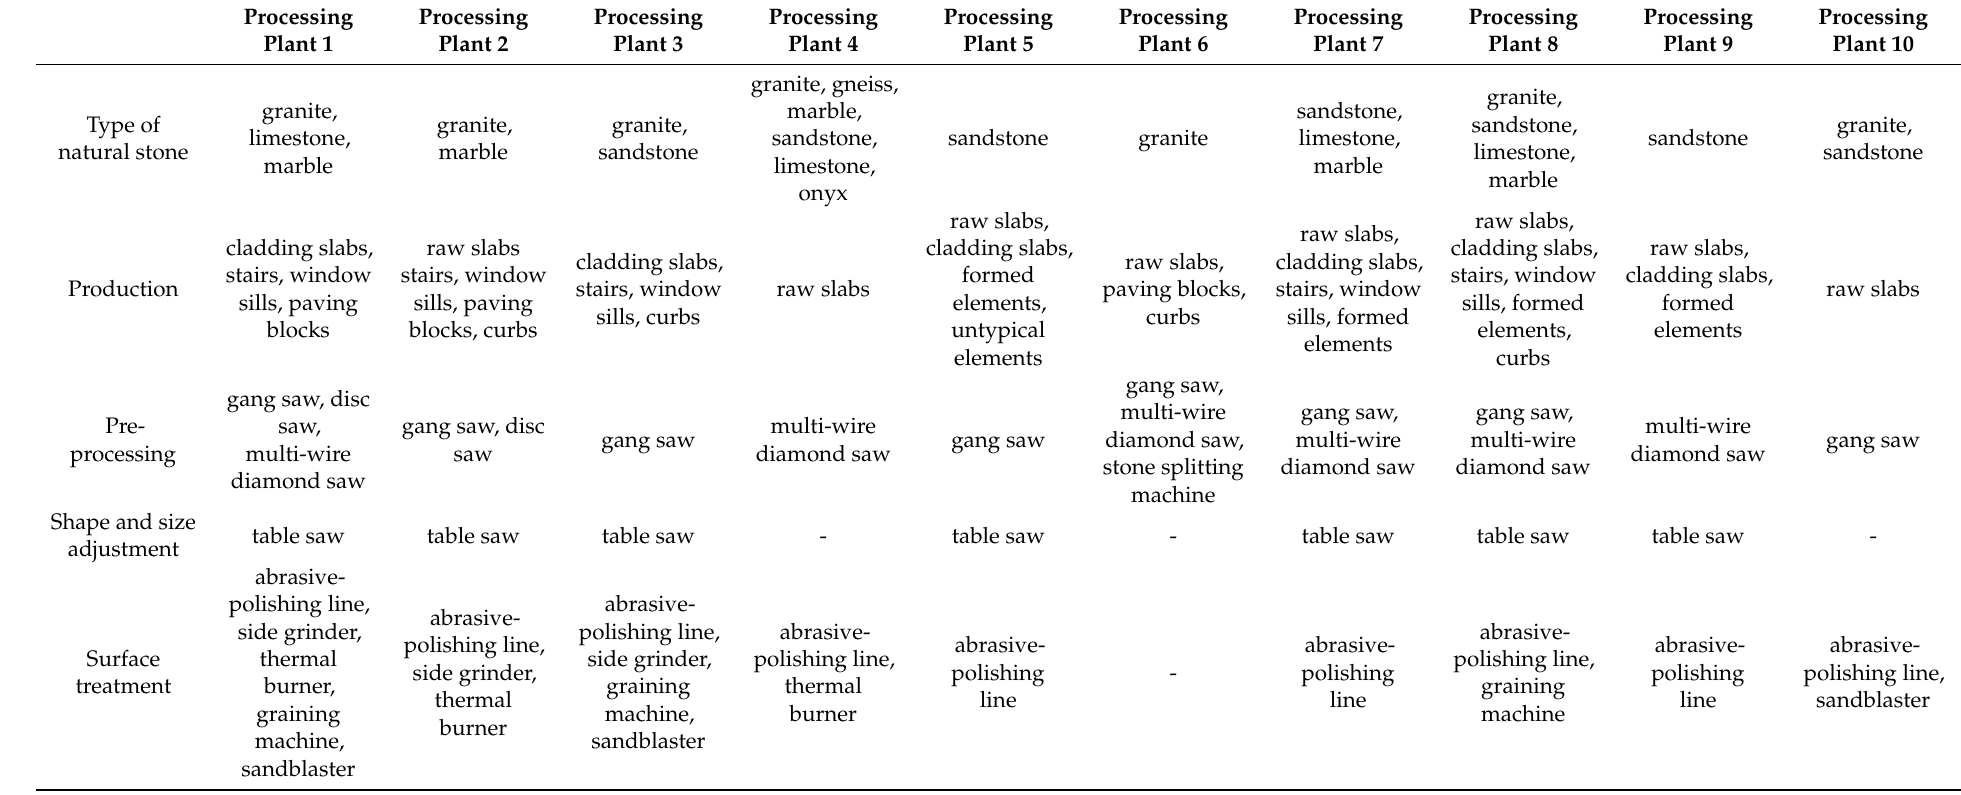
Table 2. Types of stone products and machinery used in plants in which the scale and type of stone waste were